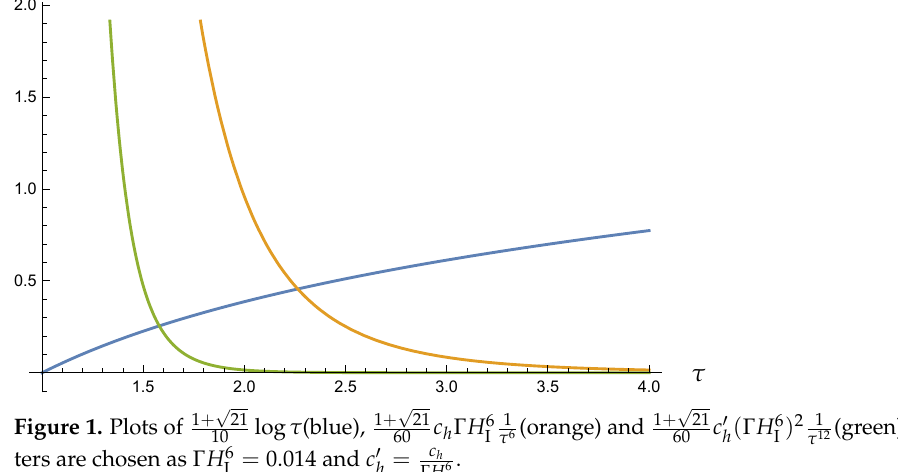
Figure 1. Plots of 1 + ters are chosen as Γ H 6